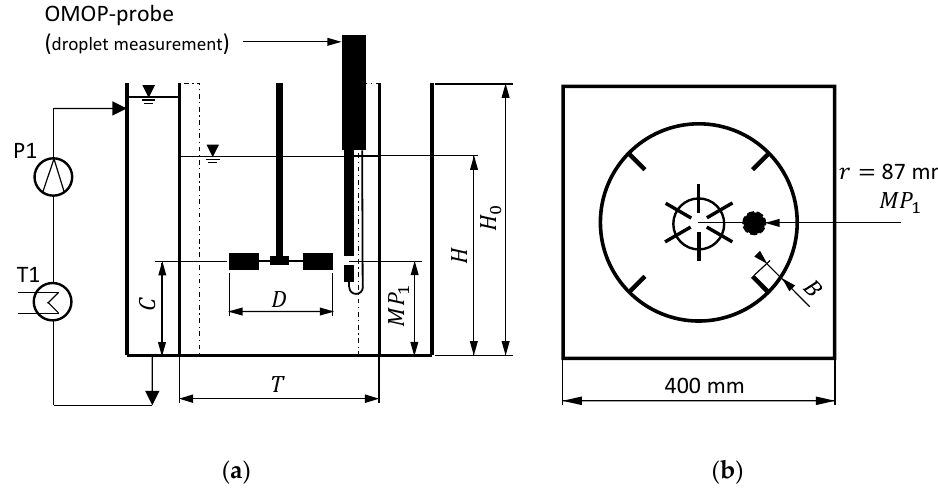
Figure 3. Experimental setup of the DN300 stirred vessel and the measurement position MP 1 of the OMOP probe; ( a ) side view and ( b ) top view of the vessel.